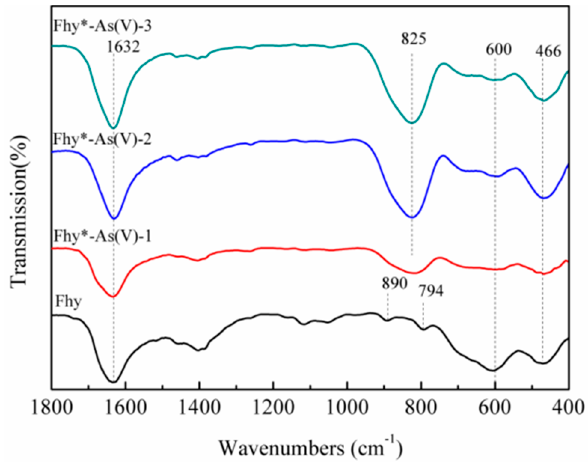
Figure 5. FTIR analysis of Fhy and Fhy*-As(V) after the photodissolution with 1.0 mM oxalic